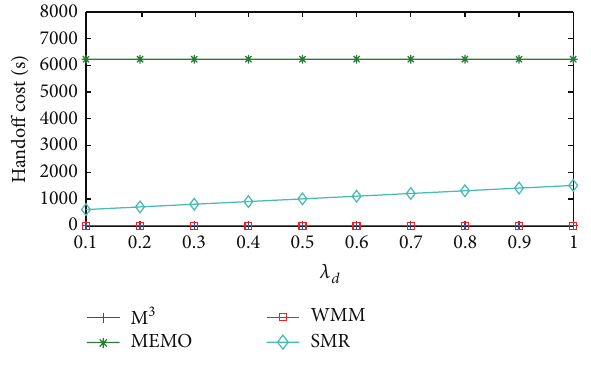
Figure 7: Handoff cost/sec versus 𝜆 𝑑